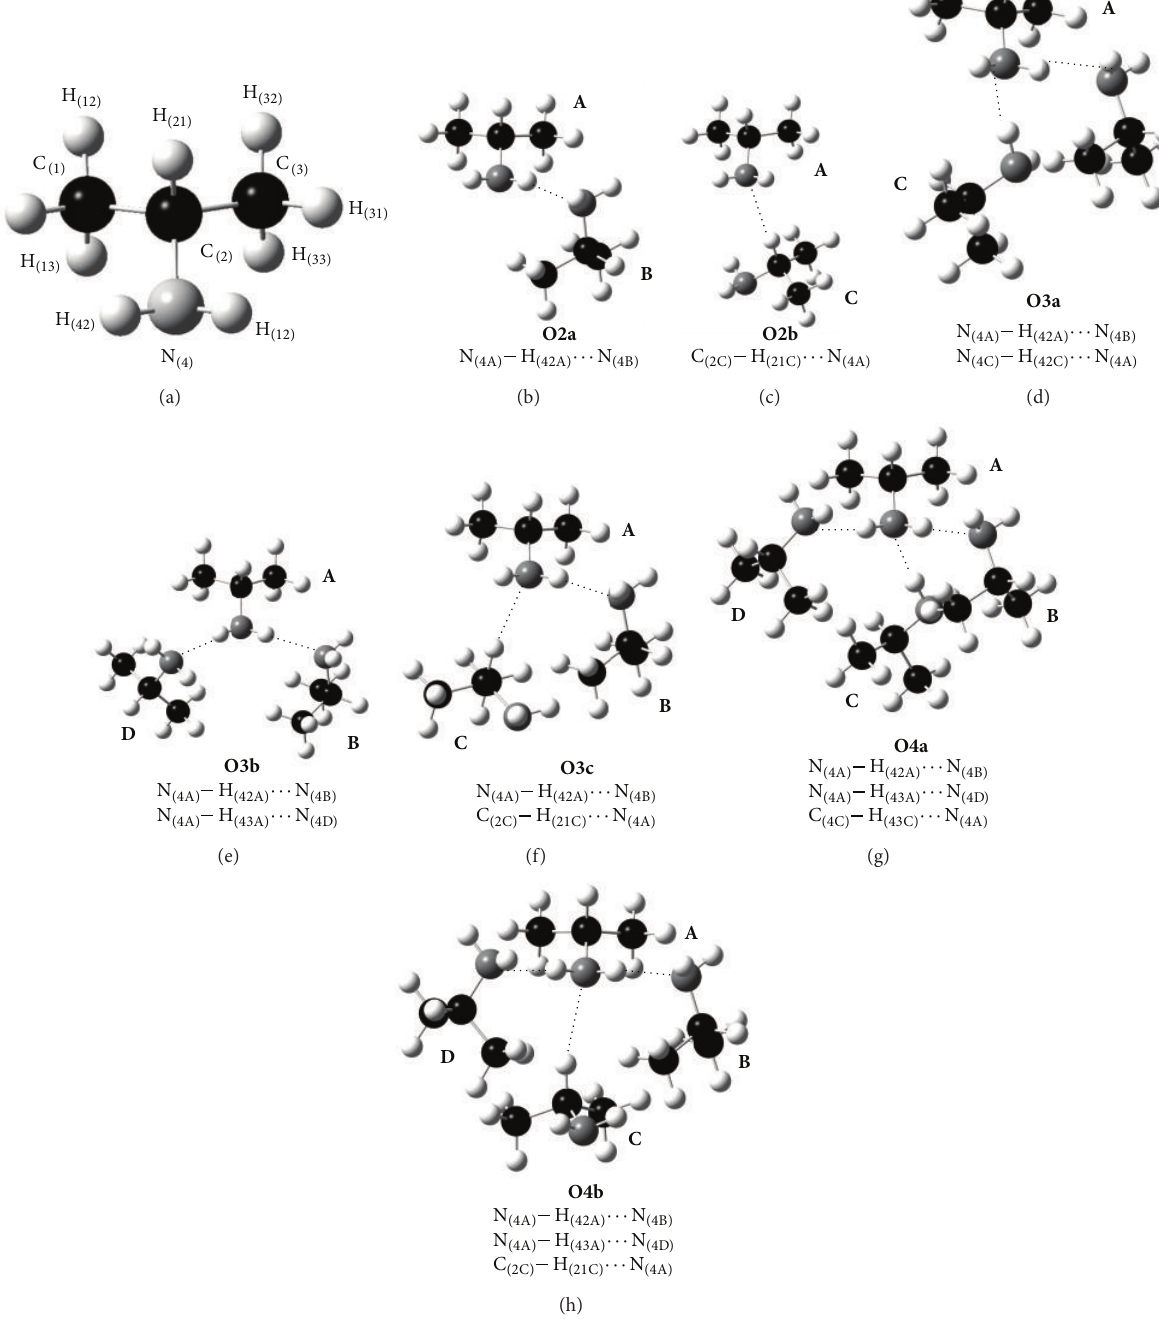
Figure 1: Representation of the different oligomeric species considered in the work. In all cases, each iPram unit was considered in the trans -form. The atom numbering used throughout the text and tables is